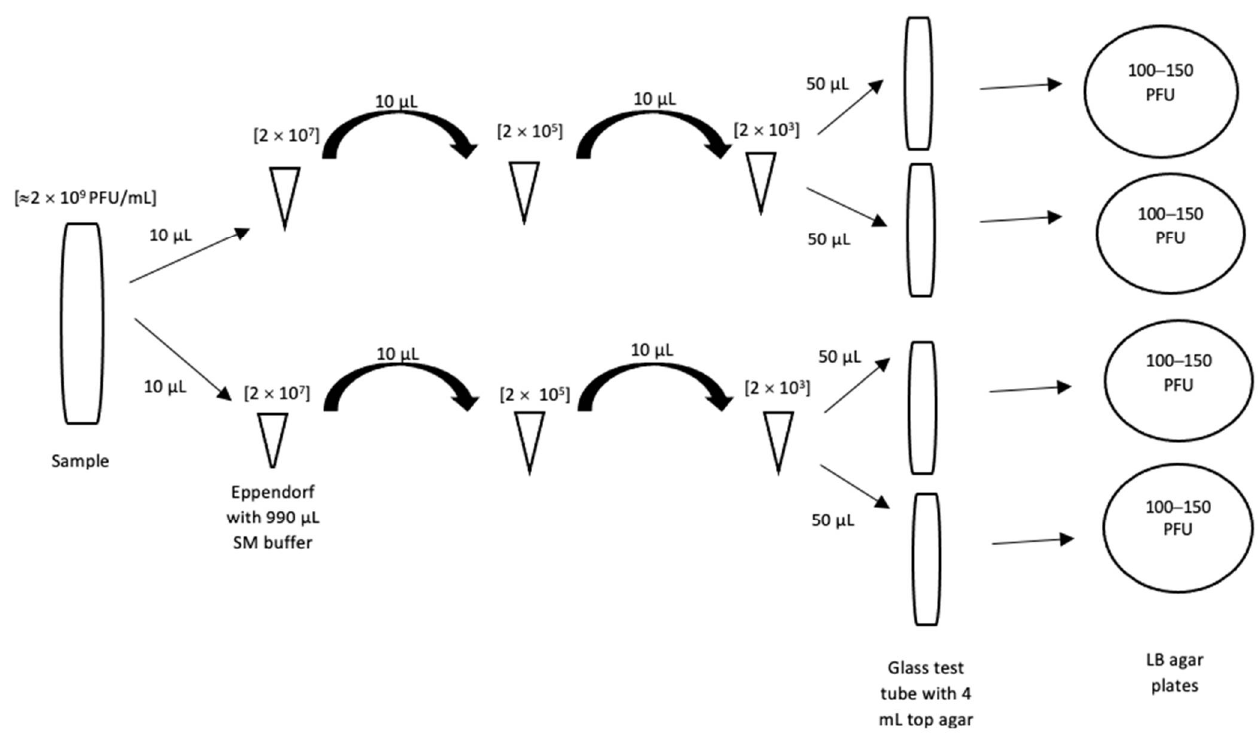
Figure 1. Schematic representation of a titration of a 1% PGS sample.